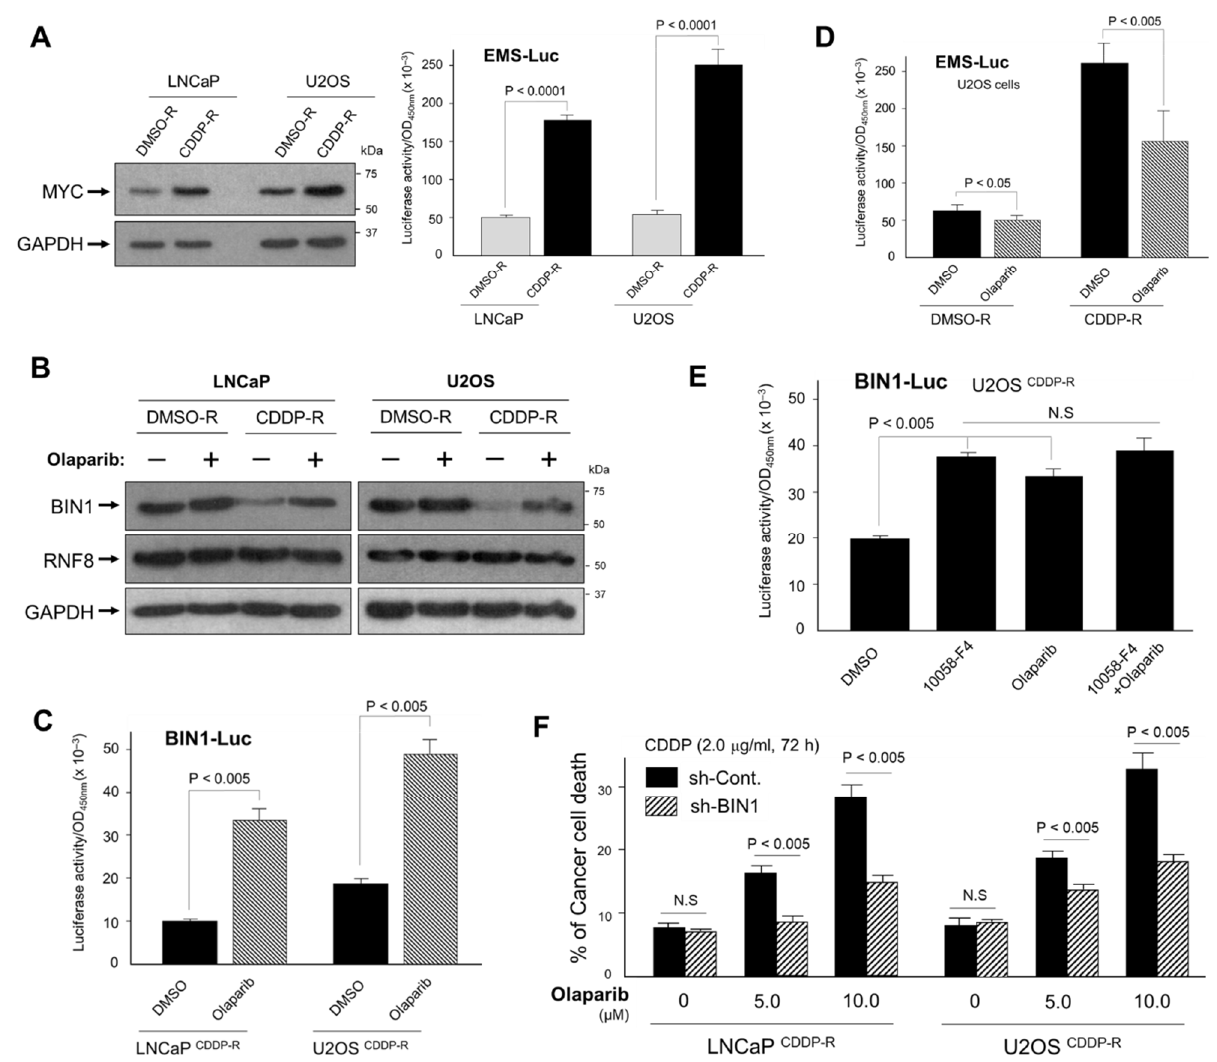
Figure 6. Coordinated actions of MYC and PARP1 play a critical role in BIN1 reduction and following cisplatin resistance in the CDDP-R cell lines. The increased activity of the neoplastic MYC transcription factor depends greatly on increased PARP activity in the CDDP-R cancer cells, thus repressing BIN1 promoter activity and conversely increasing cisplatin resistance. ( A ) Western blotting analysis (left) and an EMS-luciferase reporter assay driven by the MYC-sensitive promoter sequence EMS (E-box multiple sites) (right) in the LNCaP CDDP-R and U2OS CDDP-R cell lines. The LNCaP DMSO-R and U2OS DMSO-R cell lines were used as the negative control; ( B ) Western blotting analysis of BIN1 and RNF8 ± olaparib in the indicated cell lines; ( C ) the human BIN1 gene promoter activity was monitored by the BIN1-Luc reporter ± olaparib in the indicated cell lines; ( D ) the EMS-Luc reporter assay in the U2OS CDDP-R and U2OS DMSO-R cell lines ± olaparib (5.0 µM, 48 h); ( E ) the effects of 10058-F4 (a small molecule MYC inhibitor: 16 µM, 48 h) [19] and olaparib (5.0 µM, 48 h) [20] on the BIN1-Luc reporter activity in the U2OS CDDP-R cell line; ( F ) transiently transfected sh-BIN1 significantly reversed olaparib/cisplatin-induced cancer-cell death in the LNCaP CDDP-R and U2OS CDDP-R cell lines.